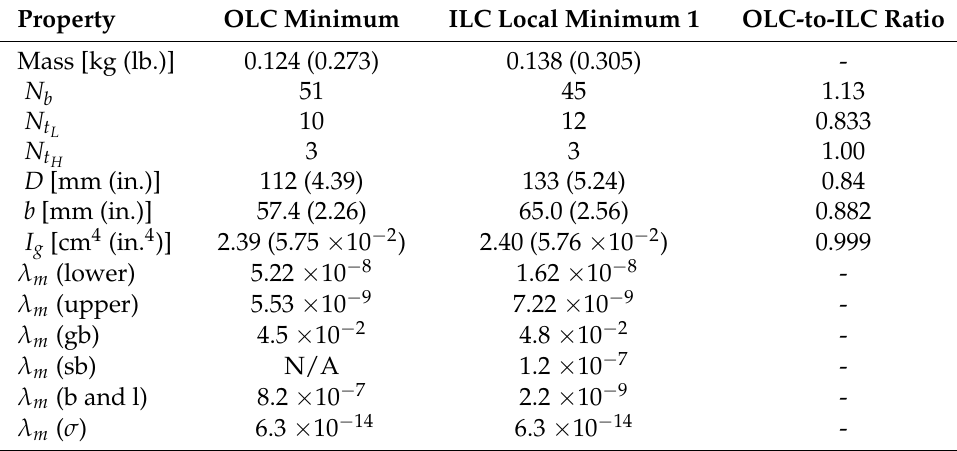
Table 6. Results of OLC and ILC Multi-modal Optimization